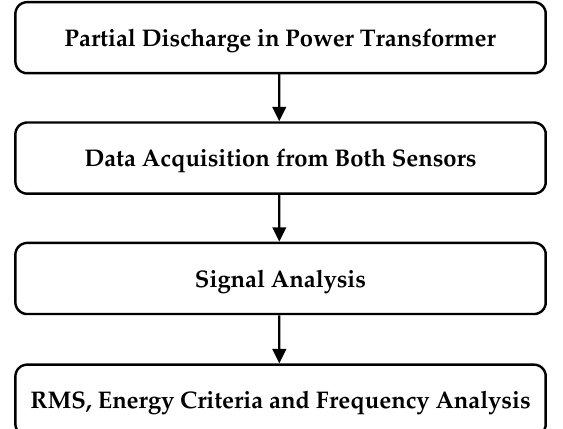
Figure 4. Signal analysis flowchart.